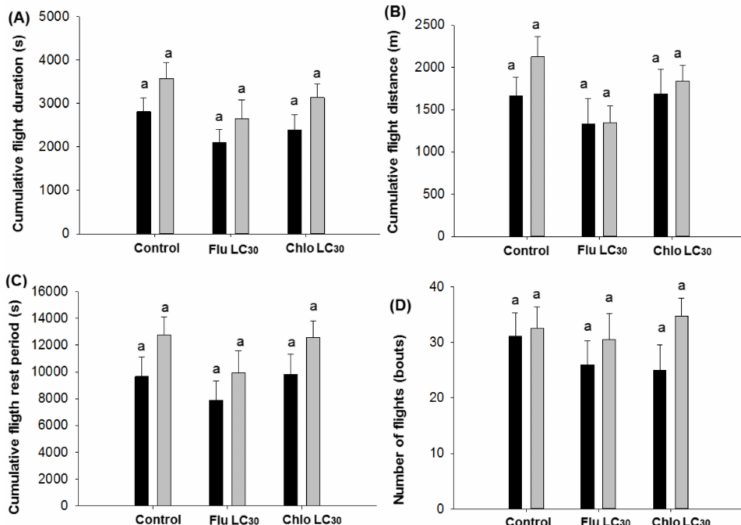
Figure 5. Chloridea virescens unsustained flights less than 30 min: (A) Cumulative flight duration, (B) cumulative flight distance, (C) cumulative flight rest period, and (D) number of flights (bouts). Black bars represent female and grey bars represent male moths. Different letters above the standard error bars indicate significant differences based on Tukey–Kramer test (p < 0.05).